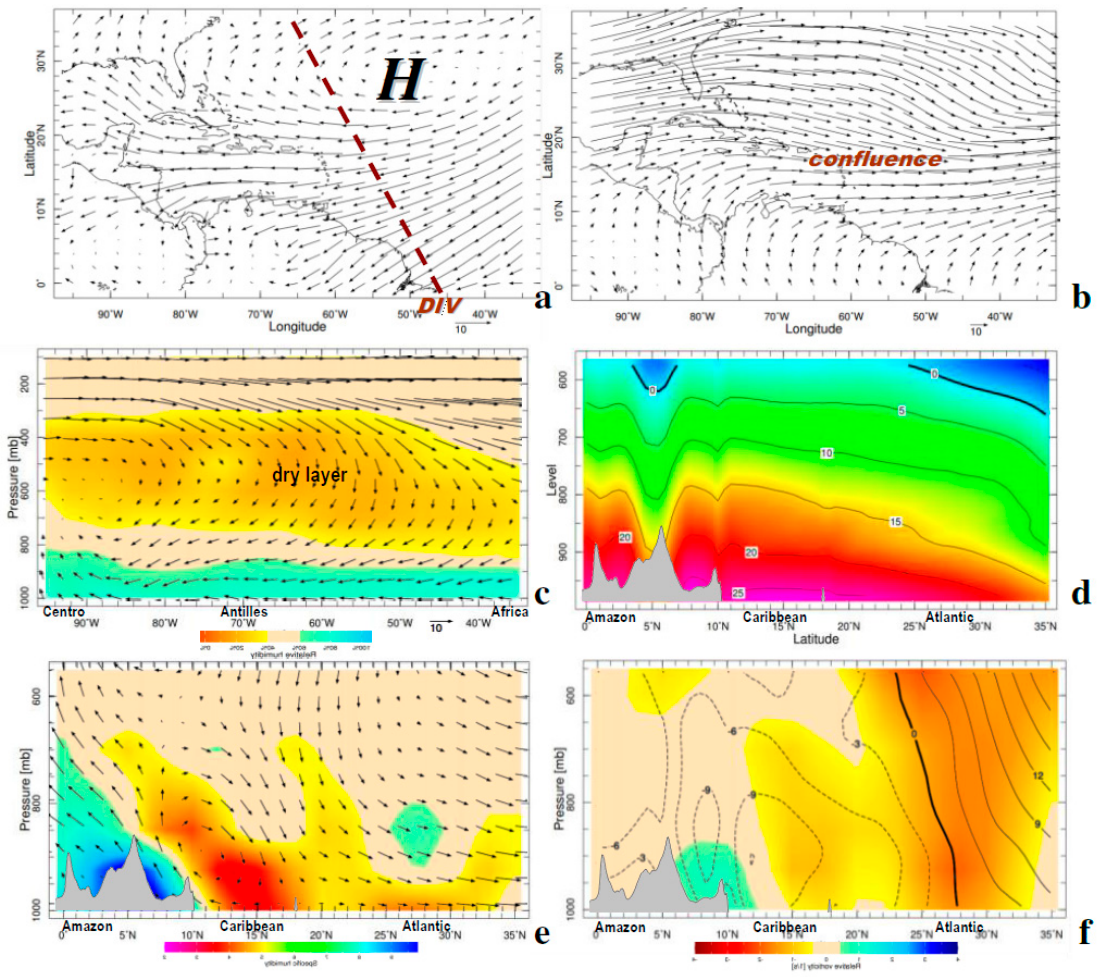
Figure 7. Composite weather patterns for the 18 highest cases with Puerto Rico air index >1.1 and OLR >260 W/m 2 : ( a ) 1000 hPa wind and axis of anomalous divergence (dashed), ( b ) 200 hPa wind. ( c ) Composite W–E section of zonal circulation (vectors) and relative humidity (shaded). Composite S–N sections in 65–67.6 ° W longitude of: ( d ) air temperature, ( e ) meridional circulation and divergence (shading 10 − 5 ), ( f ) zonal wind isotachs and vorticity (shading 10 − 5 ), with topographic profile.